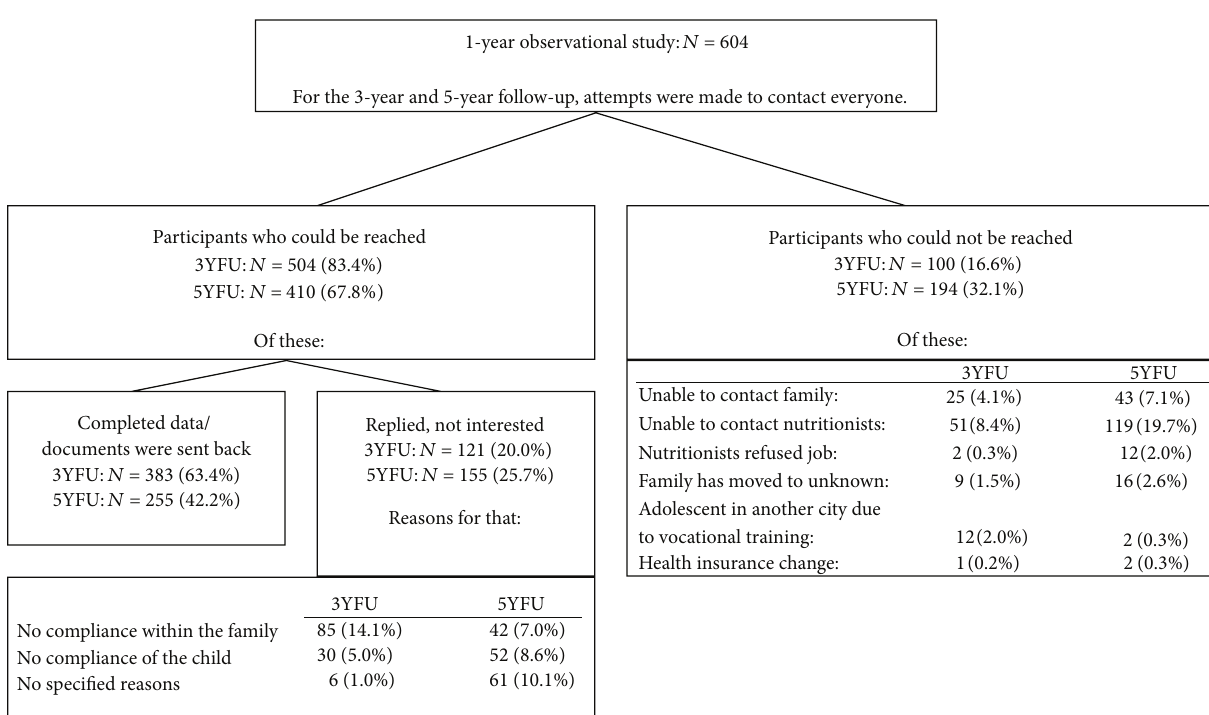
Figure 2: Flowchart of study participants. Calculations for the proportions (in %) are based on the originally included 604 participants. 3YFU: 3-year follow-up (36 month after baseline), 5YFU: 5-year follow-up (60 month after baseline).